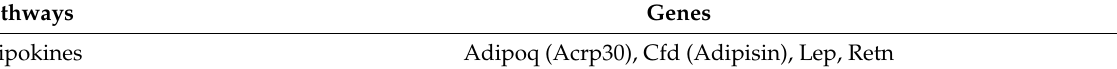
Table 2. List of selected genes in Custom Mouse RT2 Profiler PCR